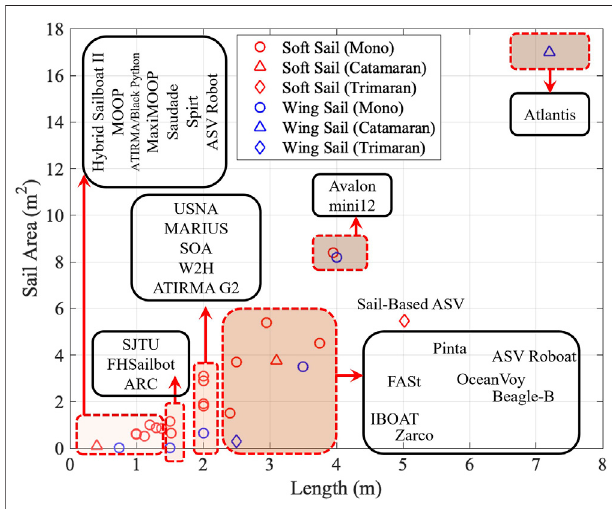
FIGURE 6 | Correlation between sail area and sailboat